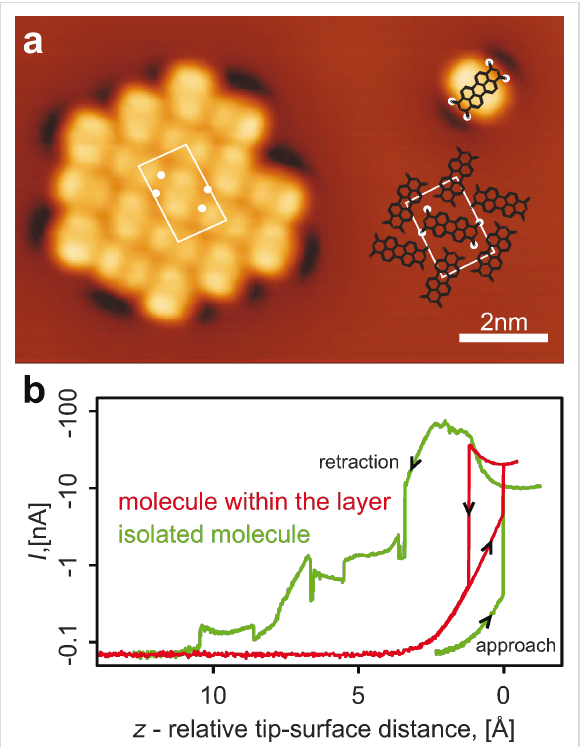
Figure 1: (a) 13 × 8 nm 2 STM image of a PTCDA island grown on an Ag(111) surface and of an isolated PTCDA molecule detached from it. The white rectangle marks the unit cell of the monolayer. The struc- ture of the PTCDA/Ag(111) layer is displayed on the right. The posi- tions of the carboxylic oxygen atoms of PTCDA are marked by white circles. All of the STM images were post-processed with WSxM soft- ware [14]. (b) I ( z ) curves measured upon tip approach and subse- quent retraction executed over one of the carboxylic oxygen atoms of PTCDA with the applied bias voltage of V = − 5 mV. Black arrows superimposed on the red and green curves show the direction of the tip movement. The contact event is observed as a sharp increase of I ( z ). The isolated PTCDA molecule can be pulled away from the surface simply by retracting the tip vertically (green curve). PTCDA molecules that reside inside monolayer islands resist pulling, which breaks their contact to the tip prematurely (red curve). The relative tip–surface distance scale ( z ) was aligned such that the contact point defined its zero